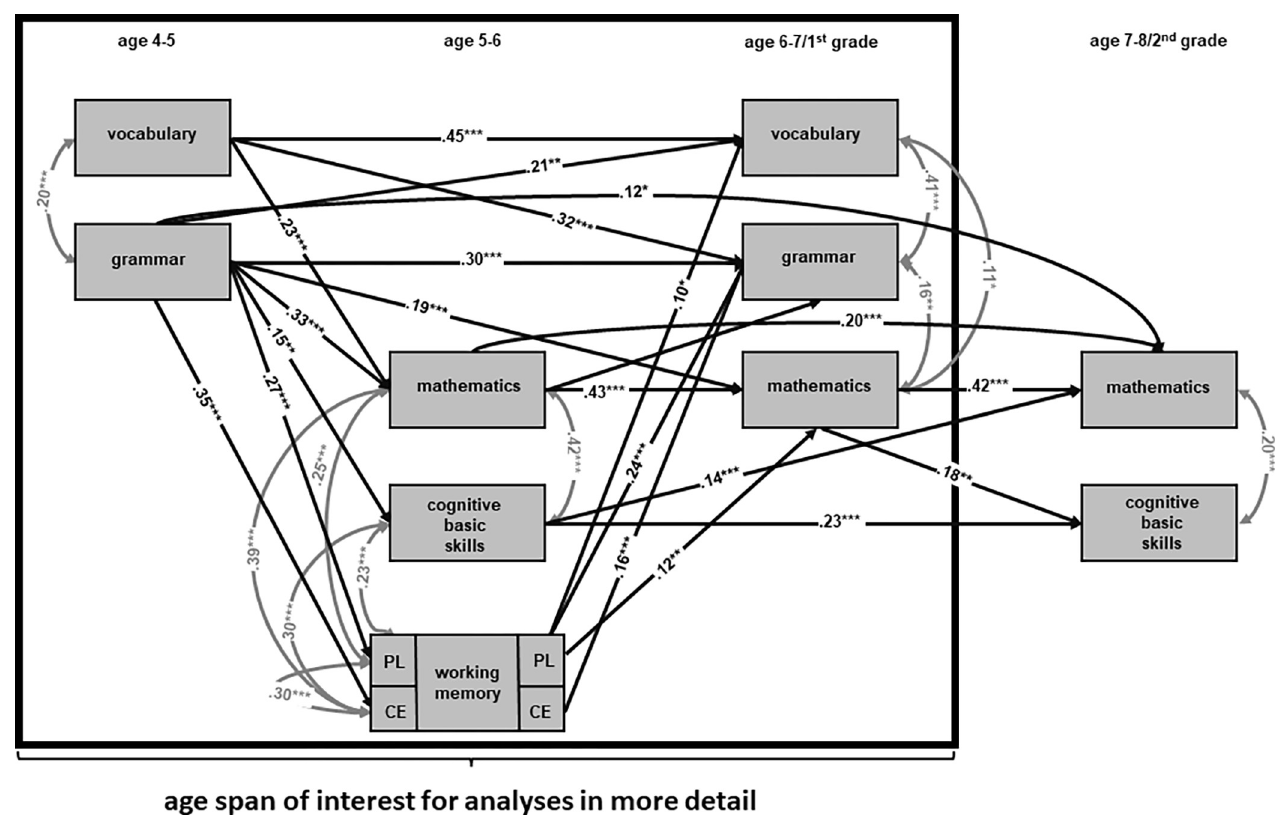
Fig 1. Already existing longitudinal results of the National Educational Panel Study ( n = 354; see p.139, Journal fu¨r Mathematik-Didaktik 2020 [8]) on the interdependencies between language skills, mathematical skills, and different working memory components within the mathematical learning process spanning preschool age until primary school